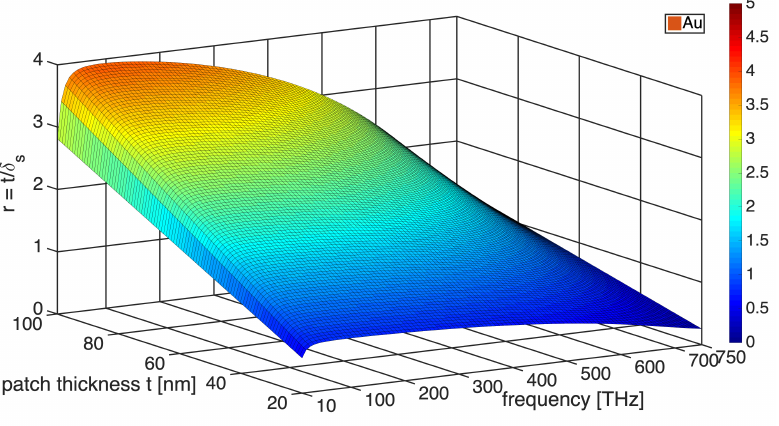
Figure 8. A 3 D representation of the ratio r = t / δ s ( δ s : penetration depth, t : thickness of metallic portions) for Au at 10–750 THz frequency range. The color scale represents the values of the ratio r